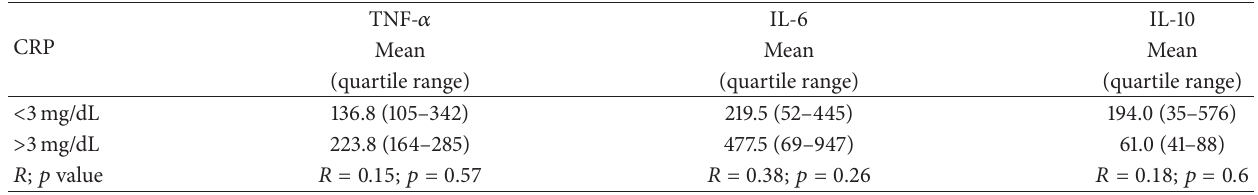
Table 4: Correlation between serum cytokine (pg/mL) and C-reactive protein (mg/dL) levels.